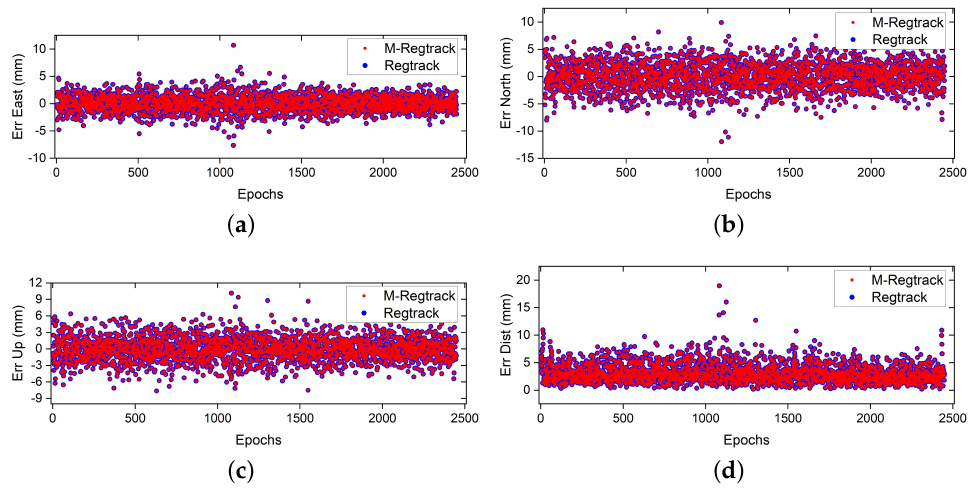
Figure 4. Error result of relative motion solution ( a ) East component error. ( b ) North component error. ( c ) Error in up component. ( d ) Error of relative motion solution, where Dist =